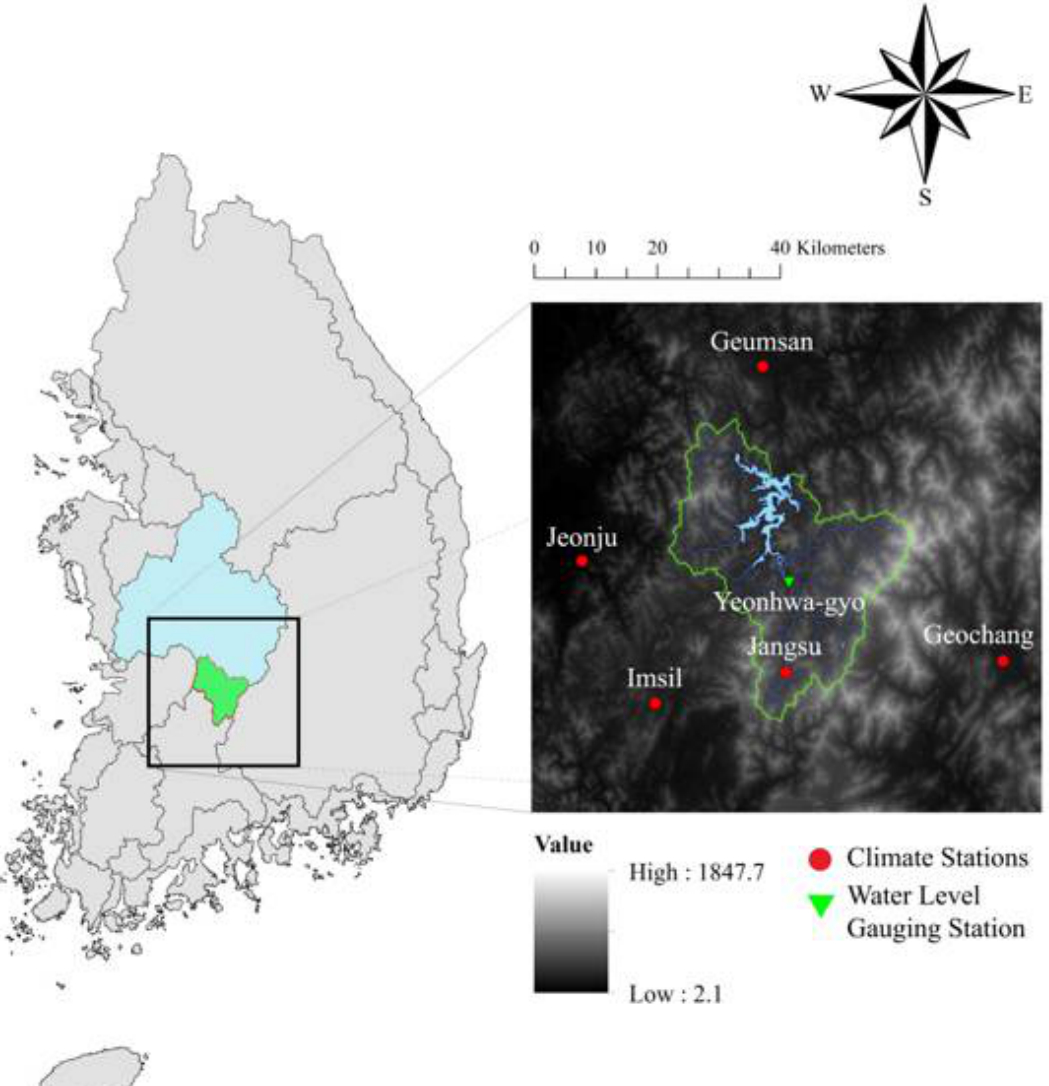
Figure 3. Location of the Yongdam watershed (green) in Geum River Basin (blue) and the location of all climate, and water level gauging stations utilized in this study.